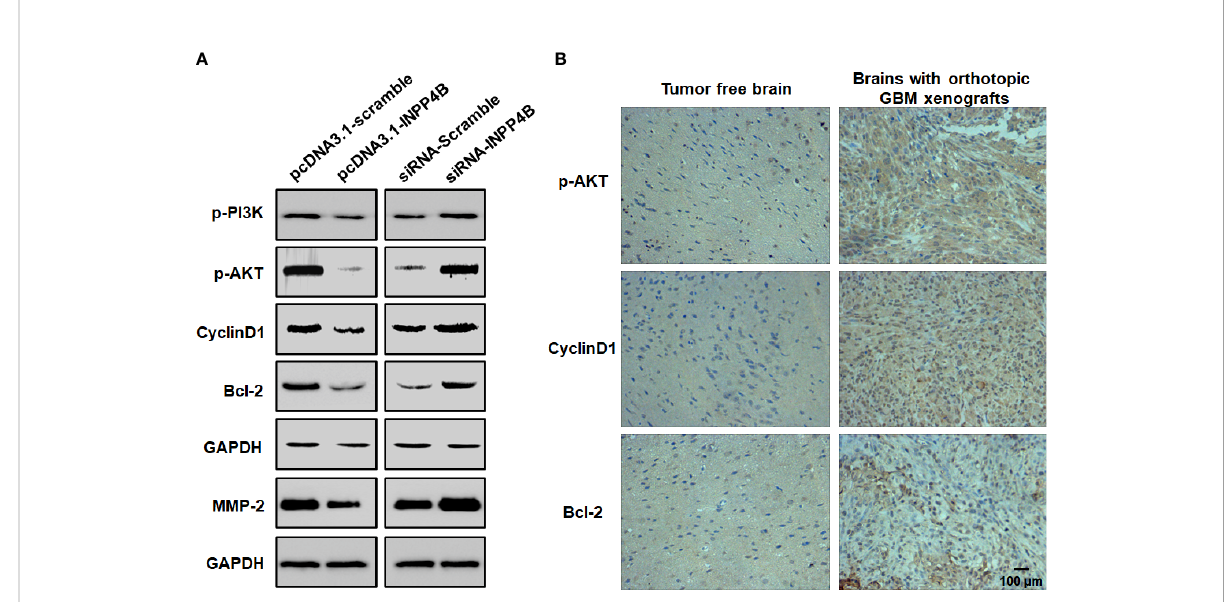
FIGURE 4 INPP4B negatively regulates PI3K/Akt signaling in glioma cells. (A) Quanti fi cation of p-PI3K, p-Akt, Cyclin D1, Bcl-2 and MMP2 proteins by western blot in glioma cells. (B) Representative IHC analysis of p-Akt, Cyclin D1 and Bcl-2 expression in mouse orthotopic glioma cells xenografts and in normal brain tissues. Values represent the means ± SD (n = 3). Scale bar, 100 m m.